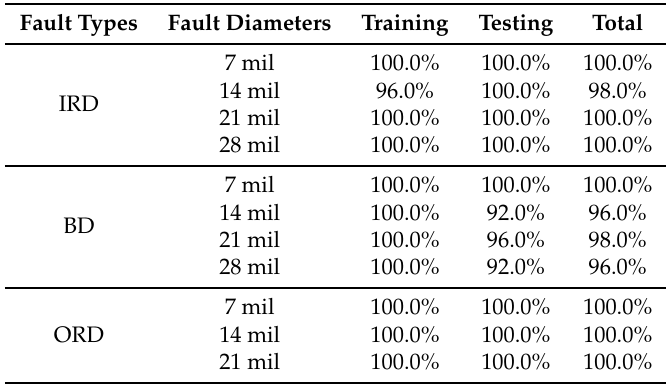
Figure 11. Classification results of fault severity levels under outer race defect. Table 10. Accuracy rate of recognition for different fault